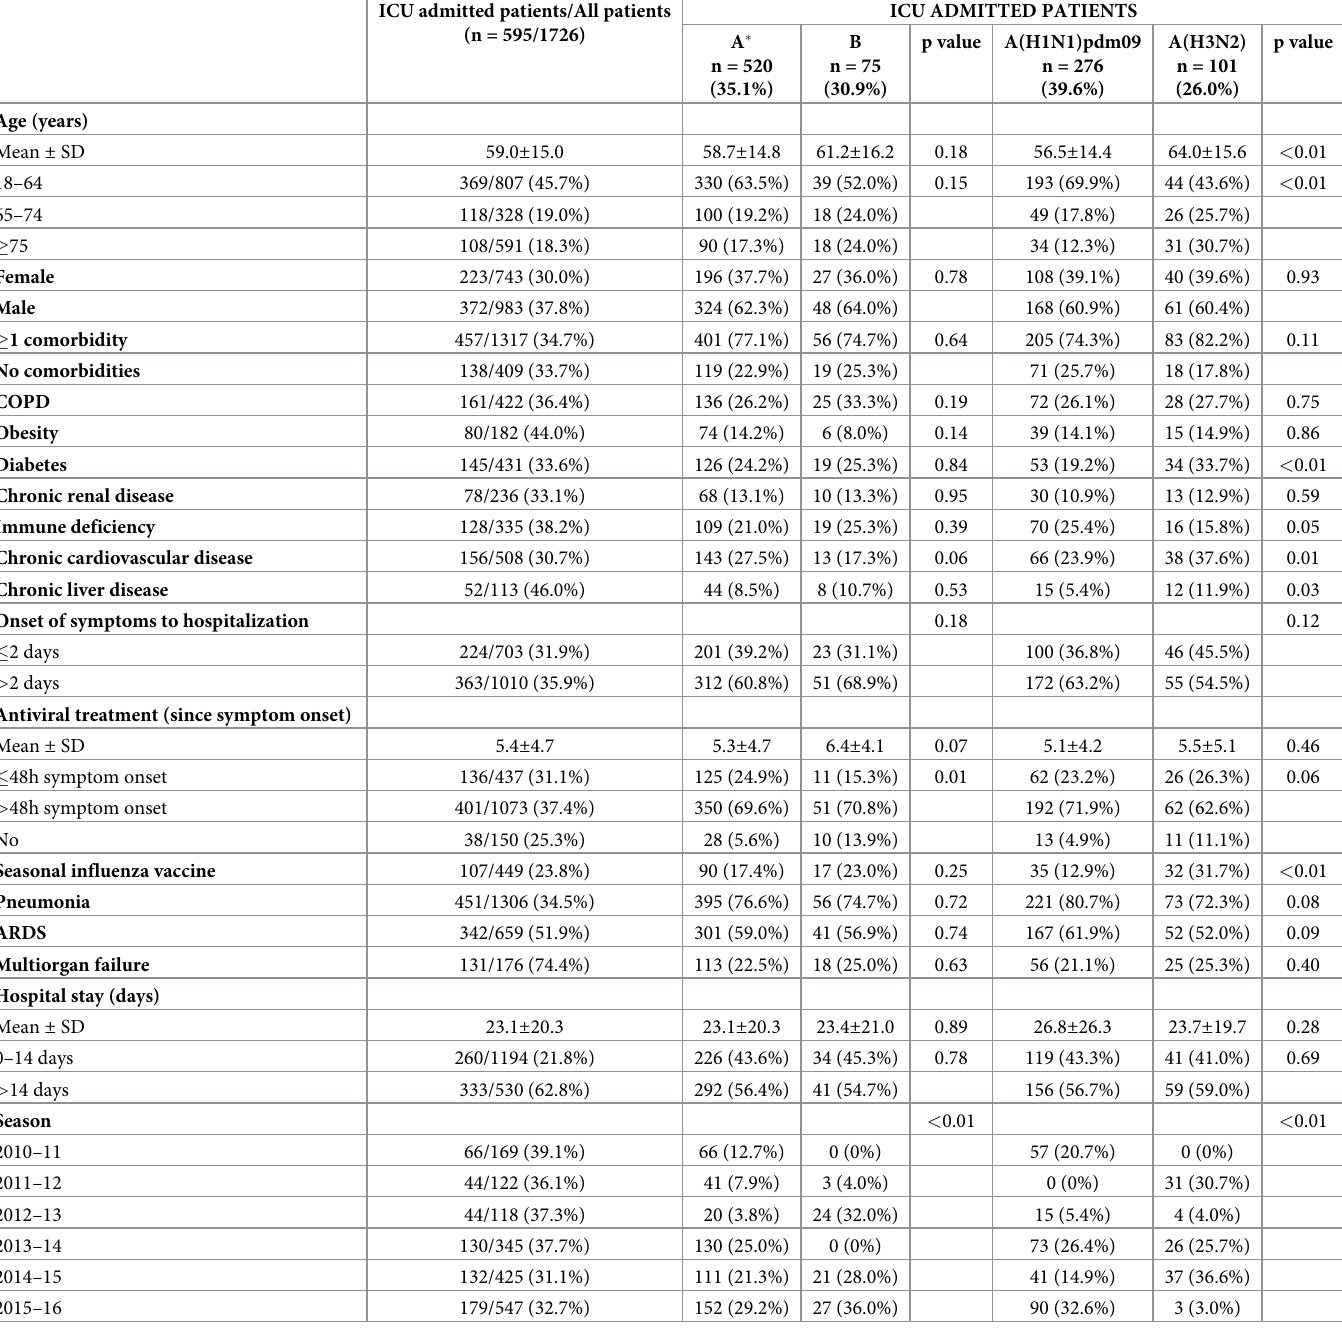
Table 2. Factors associated with ICU admission in hospitalized patients according to influenza type and